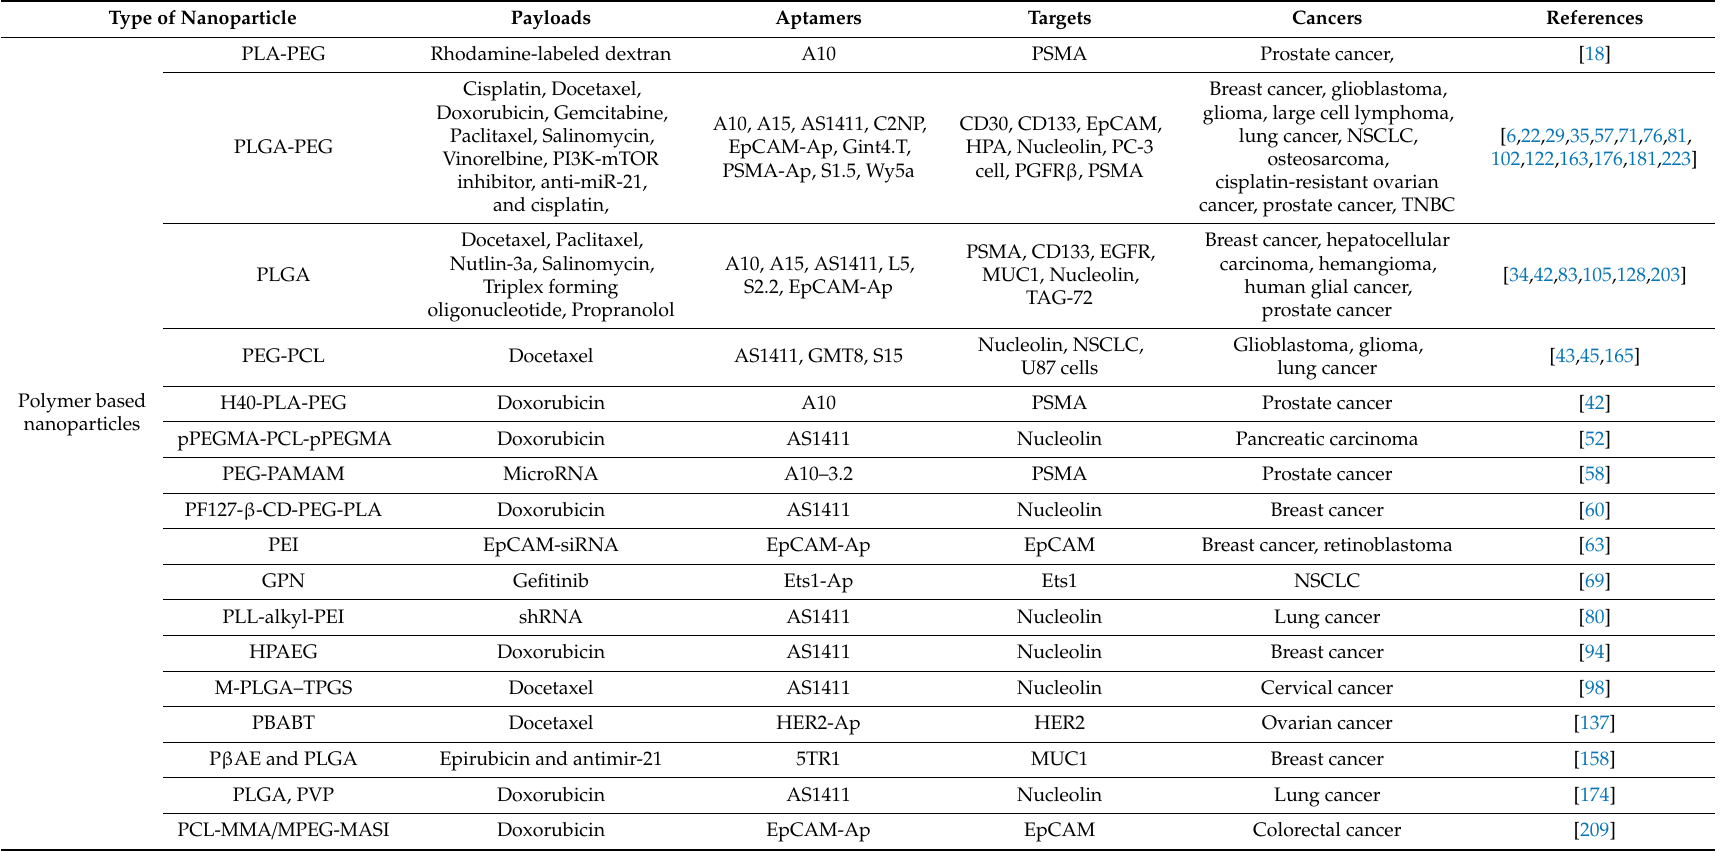
Table 2. Aptamer-functionalized nanoparticles classified by nanomaterials and